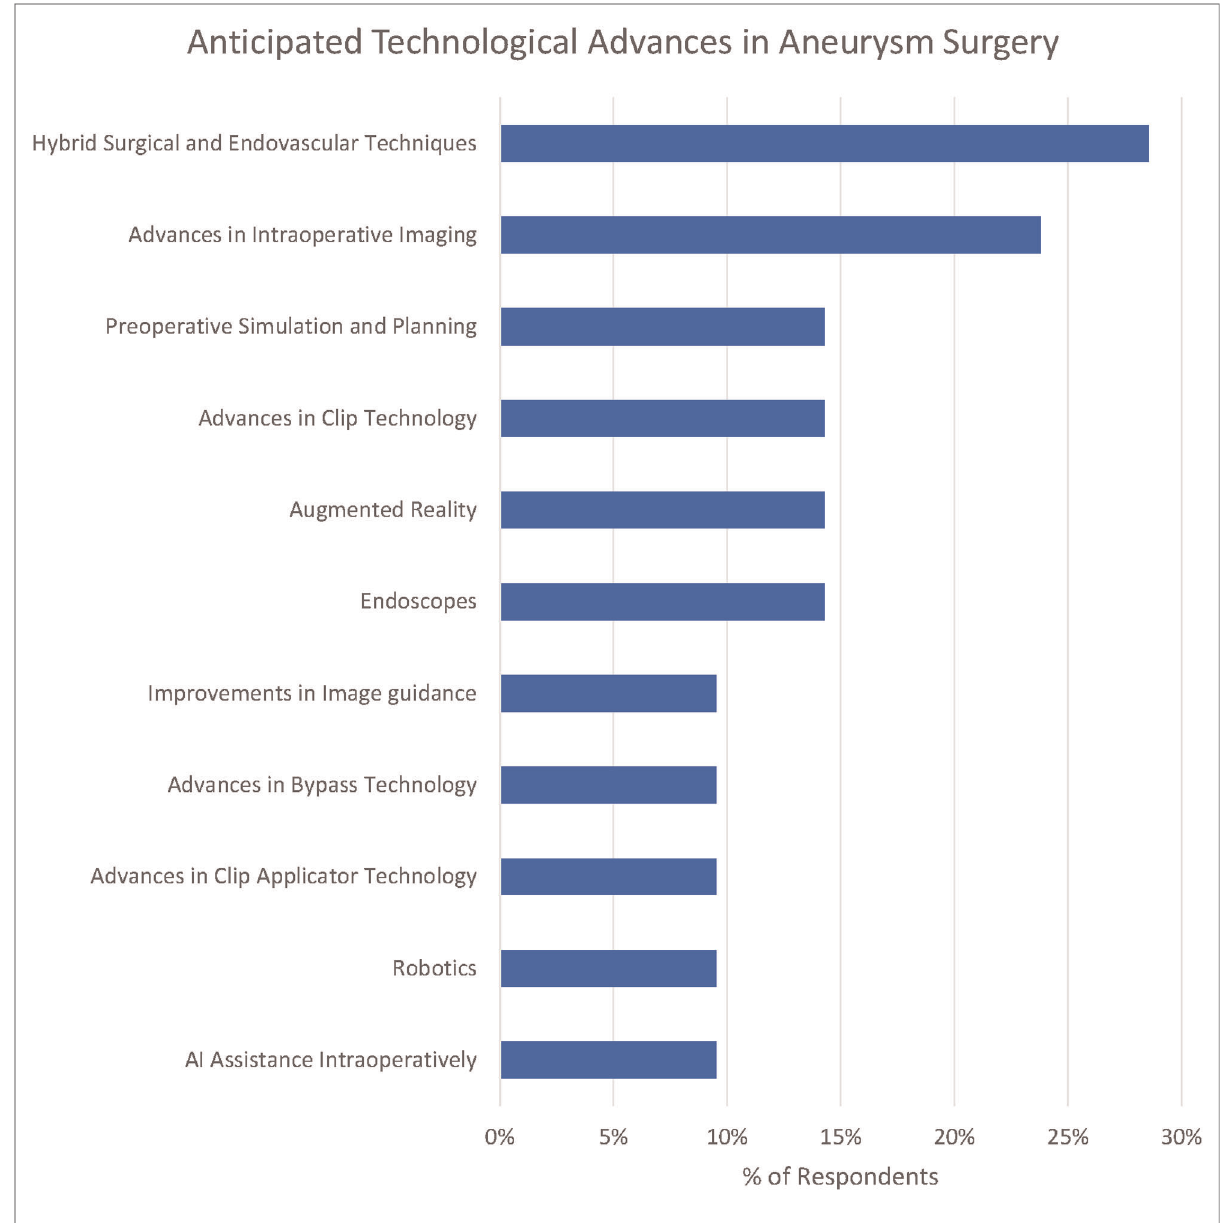
FIGURE 6 Anticipated technological advances in aneurysm